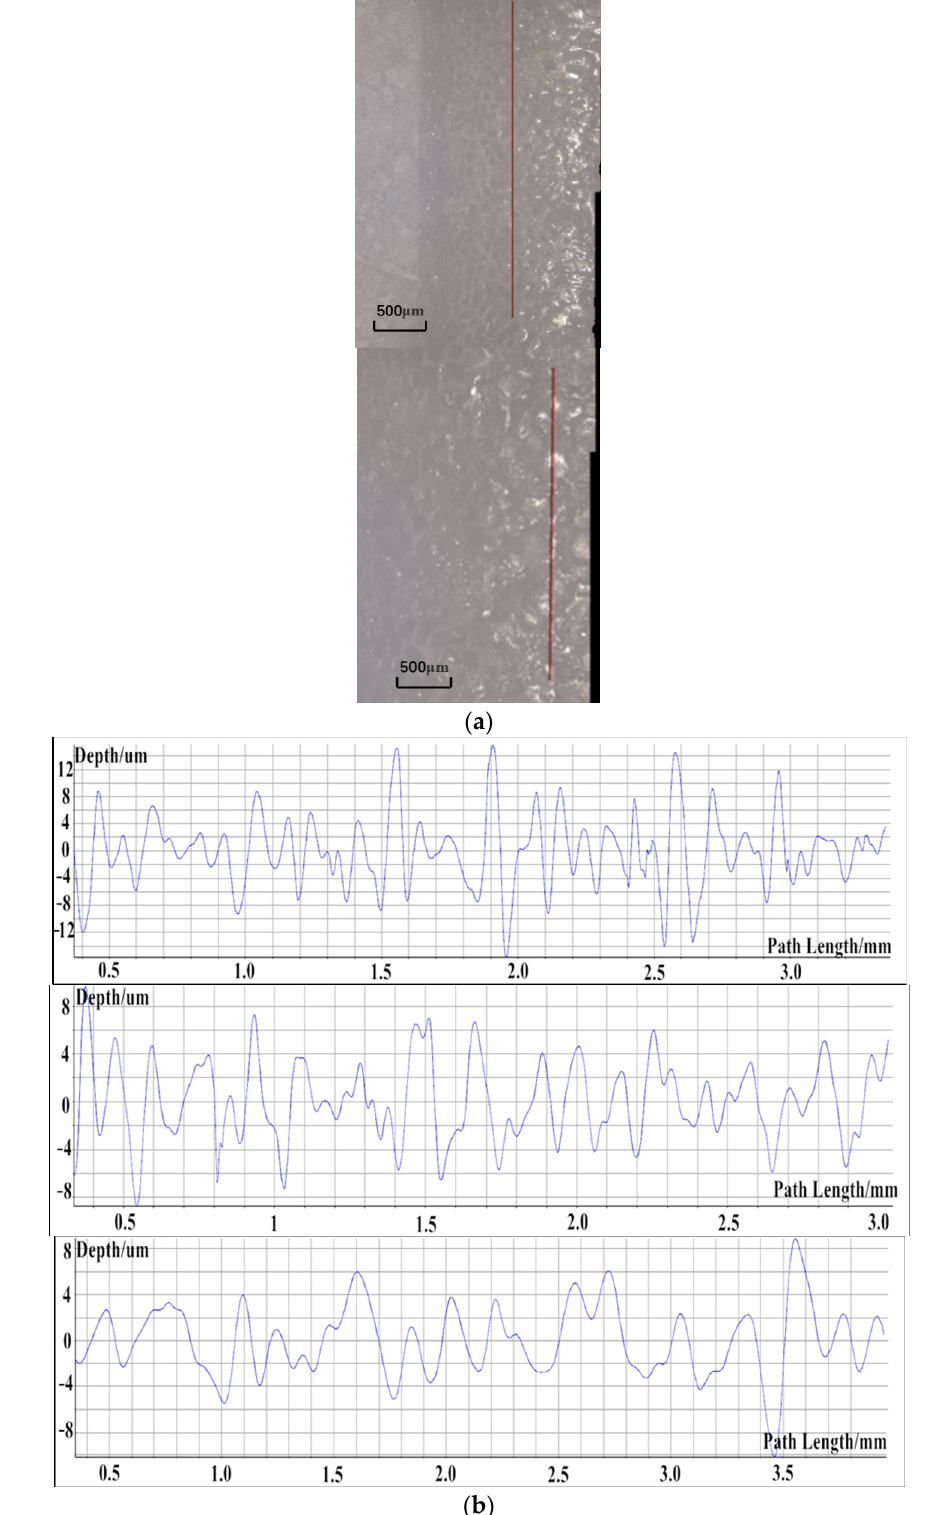
Figure 8. ( a ). Cemented carbide surface after machining (from left to right: brass, 45 steel, tungsten). ( b ). Surface roughness curve after machining with different electrodes (from left to right: brass, 45 steel, tungsten).